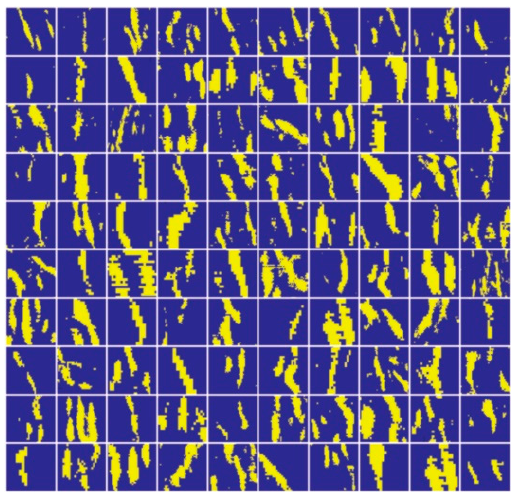
Figure 6. Partial display of tag dataset.